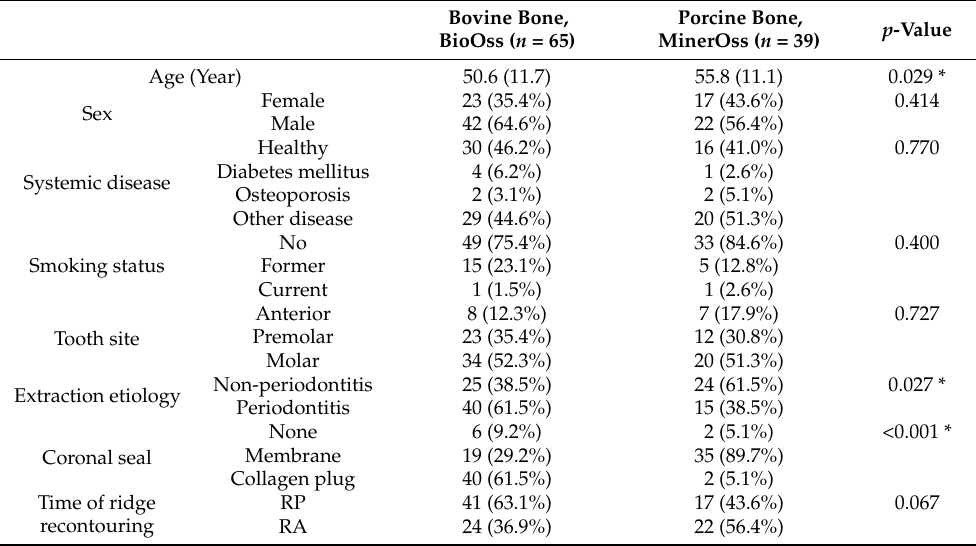
Table 1. Basic characteristics of maxilla implant sites for bovine and porcine bone groups.